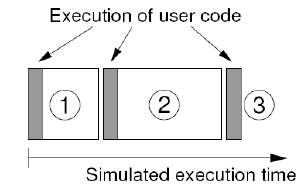
Figure 3. TrueTime code model. The execution of task code (or user code) is modelled by a sequence of code segments that are executed in sequence by the kernel.